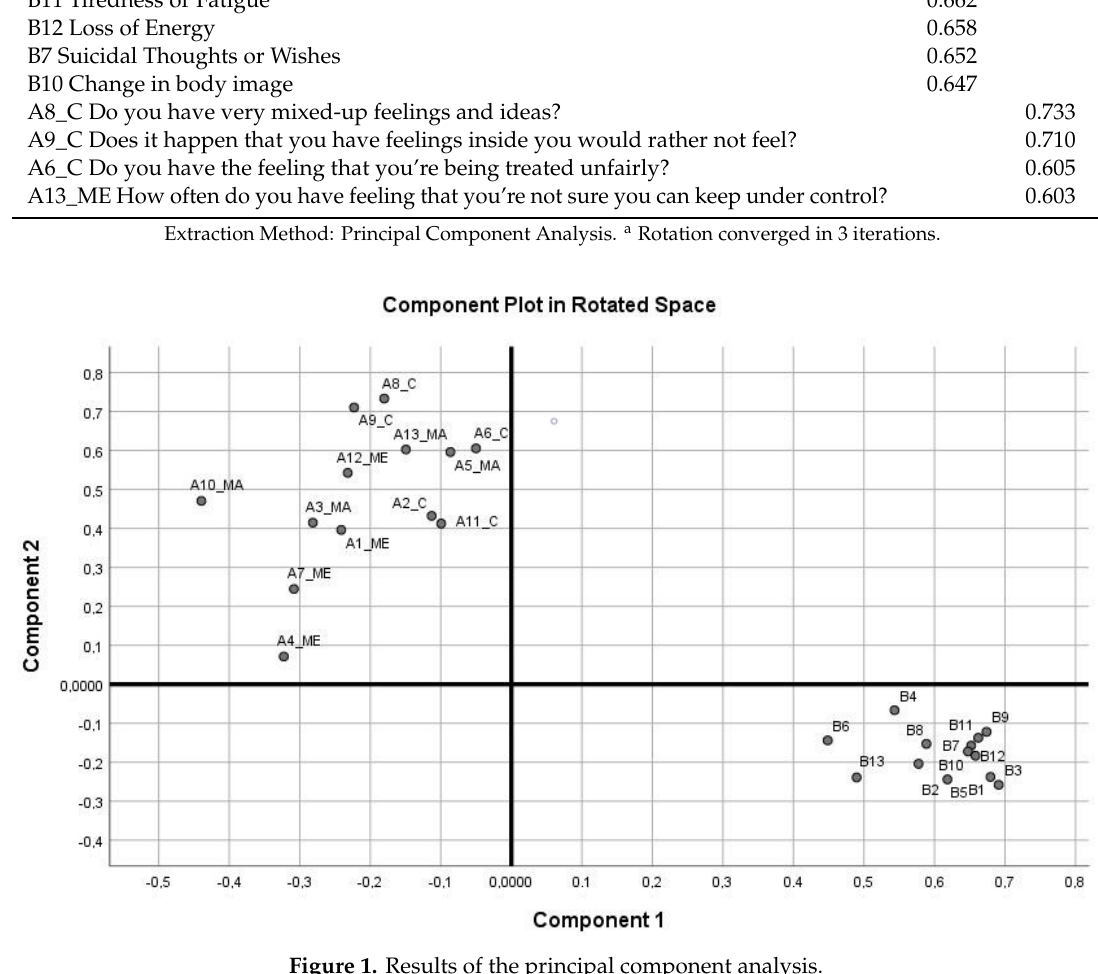
Table 6. Binary logistic regression analysis of the depression-factor and sense of coherence-factor to energy drink addiction, controlled for age and sex.